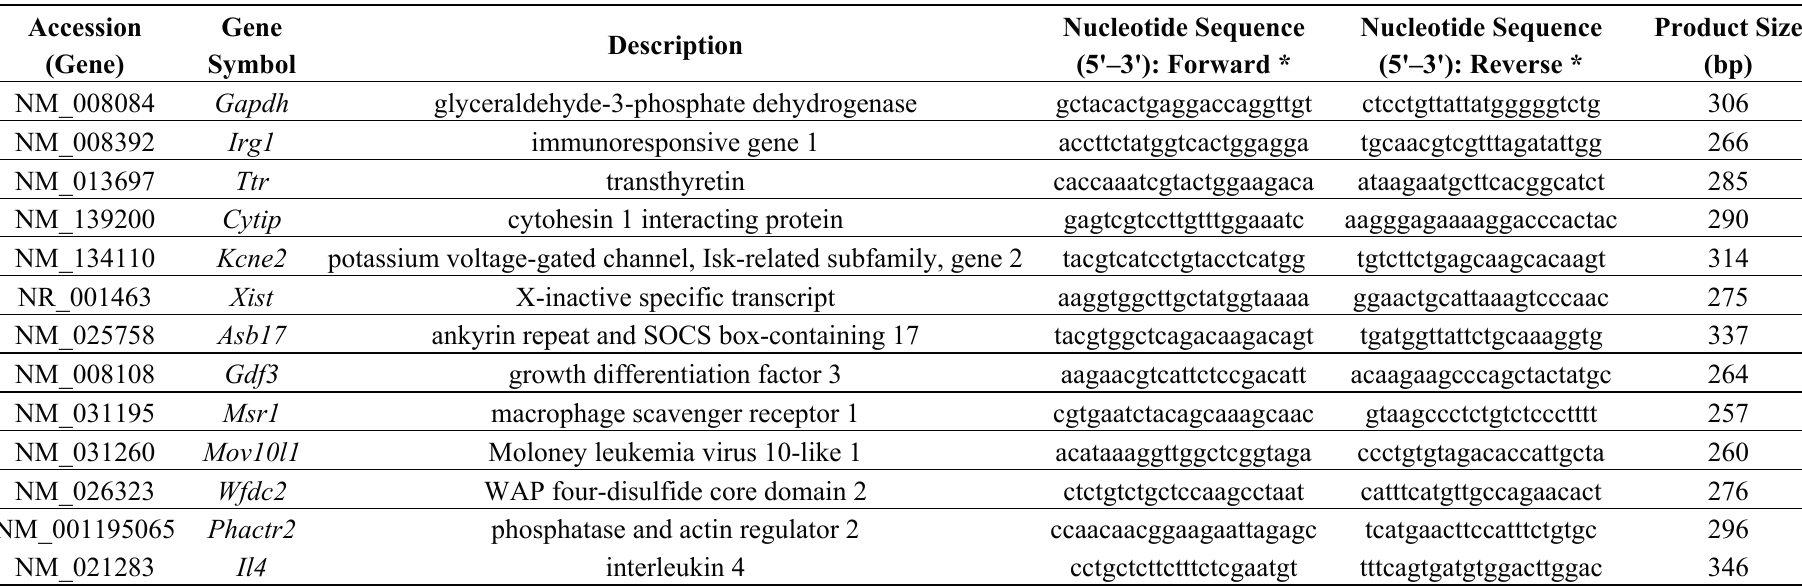
Table 1. Primer design for RT-PCR validation experiment. Primers are designed in-house and original to our